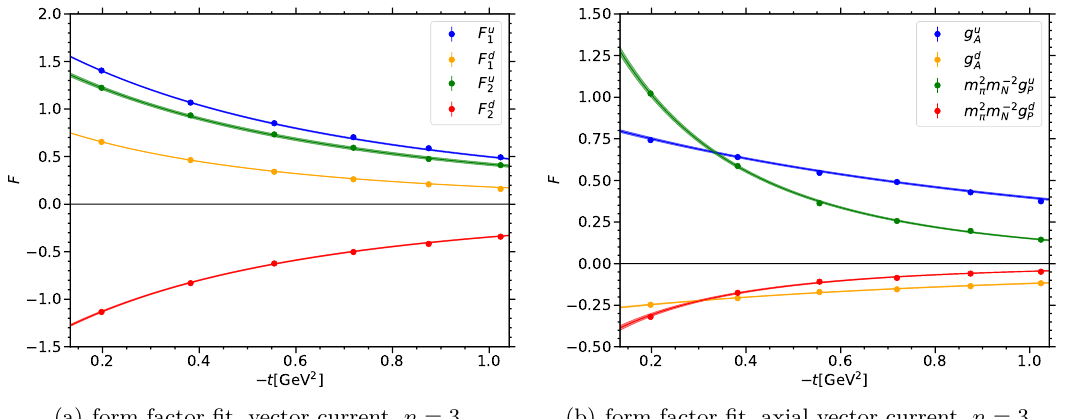
Figure 24 . t -dependence of the form factor data points and the corresponding curves obtained from a fit to the ansatz (5.16) with n = 3 . This is shown for the Pauli and Dirac form factors in panel (a), as well as for the axial and pseudoscalar form factors (b).